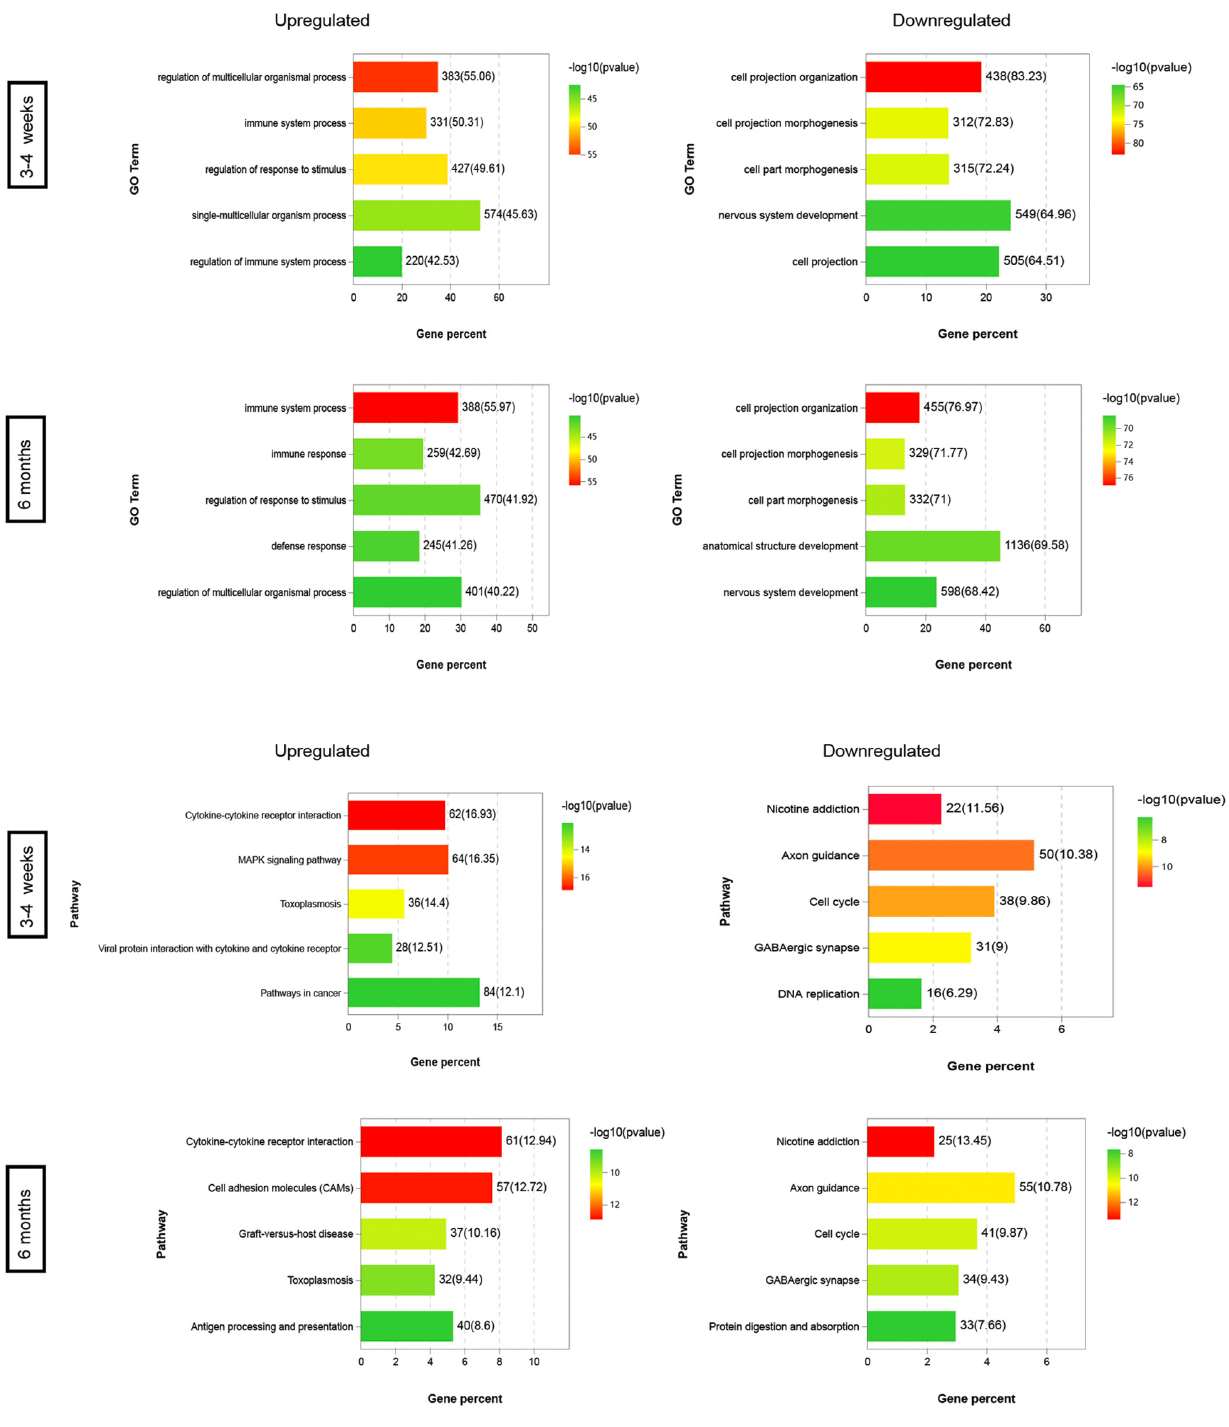
Frontiers in Neuroscience |